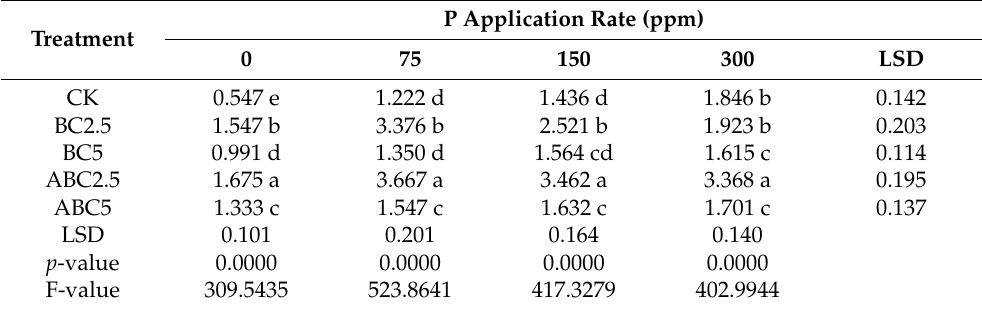
Table 15. Effects of BC and ABC applied at different rates with different P fertilizer application rates on plant dry weight in